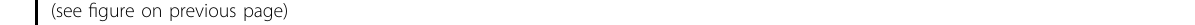
Fig. 1 Elevated nuclear proportion of PD-L1 in UM. a Flow diagram for the identi fi cation of PD-L1 subcellular localization in different types of melanomas. b Representative images of IF staining of PD-L1 in UM, CoM and SKCM samples. Scale bars, 25 µm. c Statistical results of the nPD-L1 proportion in UM, CoM and SKCM samples. Data are presented as means ± SD. Two-tailed unpaired Student ’ s t -tests. d Kaplan – Meier analysis of the recurrence-free survival of nPD-L1-positive and -negative patients. A log-rank test was used to determine the statistical signi fi cance between the nPD-L1-positive group ( n = 7) and the nPD-L1-negative group ( n = 10). e Western blot analysis of cytoplasmic/membrane (C/M) and nuclear (N) fractions of PD-L1 in different types of melanoma cell lines. f IF staining of PD-L1 in different types of melanoma cell lines. Left panel, representative IF staining images. Scale bars, 10 µm. Right panel, colocalization analysis of PD-L1 and DAPI by ImageJ software. g Statistical analysis of nPD-L1 fl uorescence intensity (%) in Fig. 1f. n = 20. Data are presented as the means ± SD. Two-tailed unpaired Student ’ s t